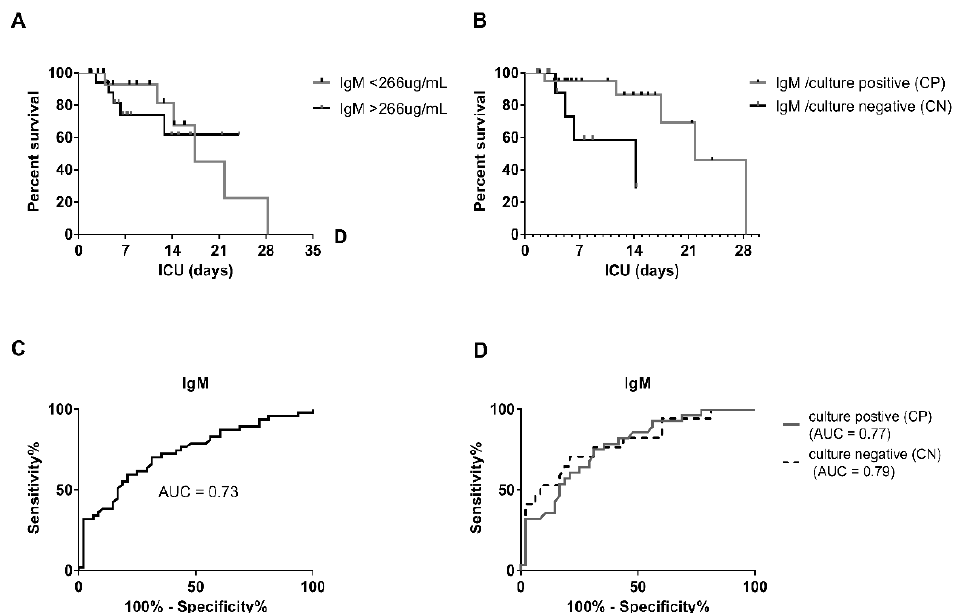
Figure 3. Survival and discrimination ability based on IgM levels in sepsis. ( A ) Kaplan–Meier survival curve based on IgM levels; ( B ) Kaplan–Meier survival curve based on culture positive or negative status. ( C , D ) Receiver operating characteristic curve for IgM levels comparing sepsis with healthy controls. AUC: area under the curve.